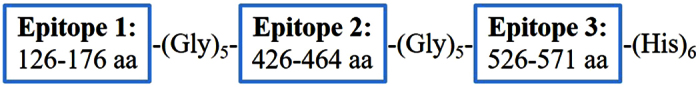
Msg RSA.Representation of the multi-epitope RSA of P. jirovecii’s Msg designed in this study. MSG1696–1851 (126–176 aa) is located at the terminal fraction of the MsgB portion, while MSG2596–2712 (426–464 aa) and MSG2896–3033 (526–571) are integrated at the C-termini of the MsgC portion, according to the sequence with GenBank accession no. JN792933.1.